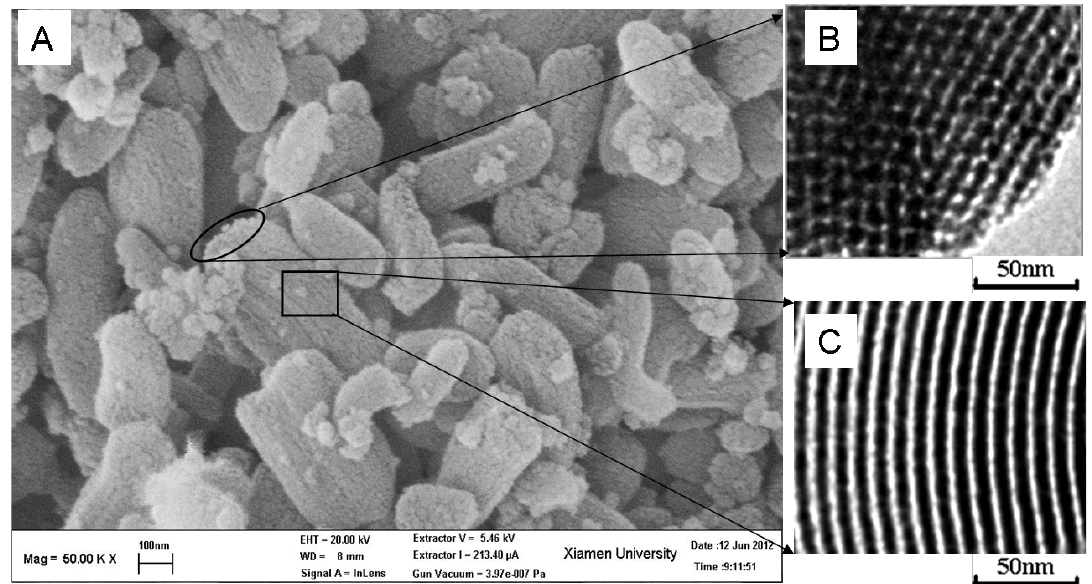
Figure 3. Scanning electron microscopy (SEM) and transmission electron microscopy (TEM) images of